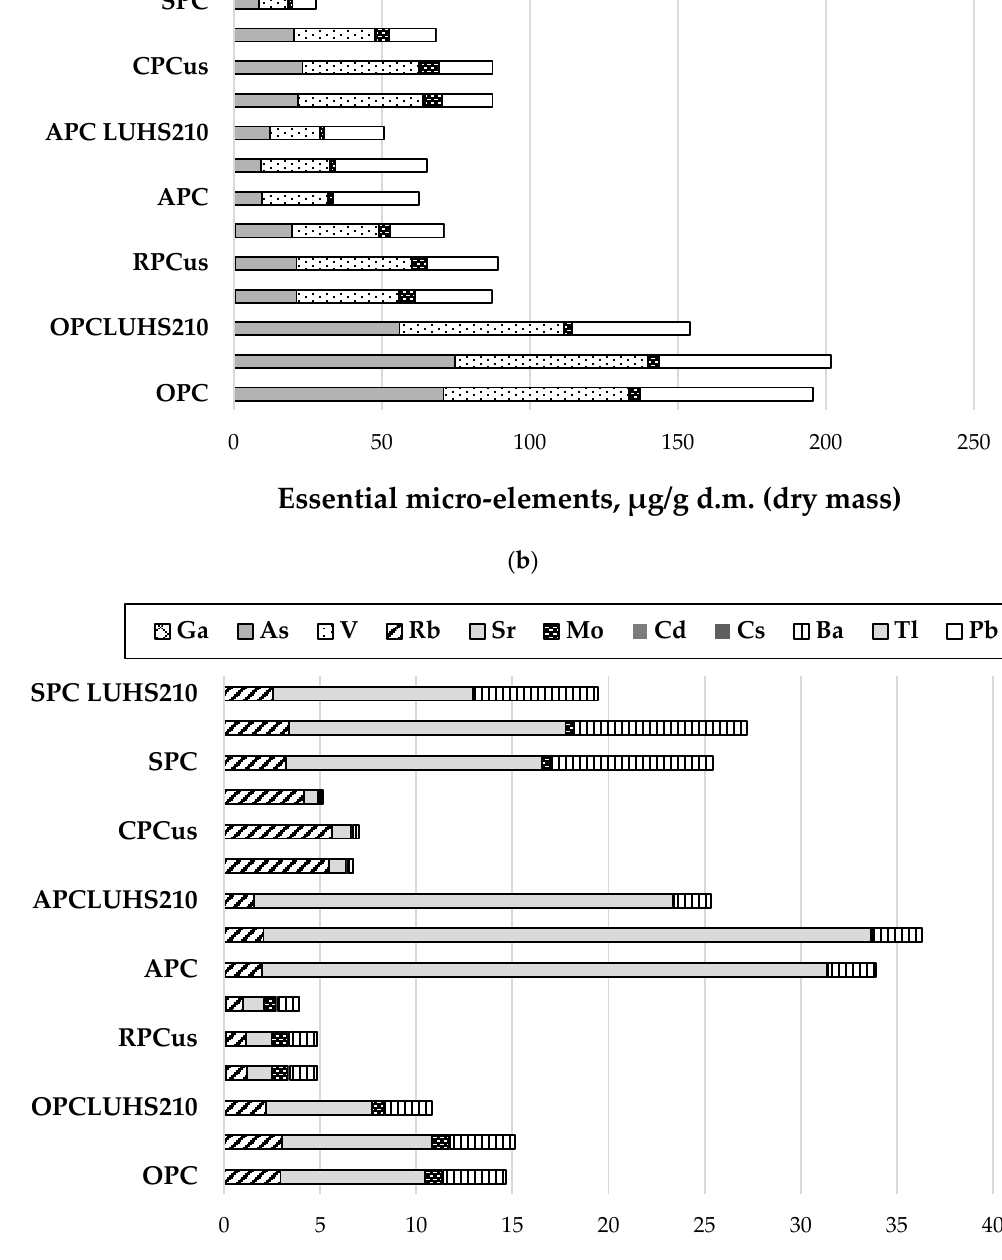
Figure 3. ( a ) Macro-elements, ( b ) essential micro-elements, and ( c ) non-essential micro-elements concentration in ultrasound treated and fermented with LUHS210 strain byproducts. Data are represented as means ( n = 3) ± SD. RPC — rice press cake; SPC — soy press cake; APC — almond press cake; CPC — coconut press cake; OPC — oat press cake; US — treated with 37 kHz ultrasound; LUHS210 — fermented with LUHS210 strain for 24 h.